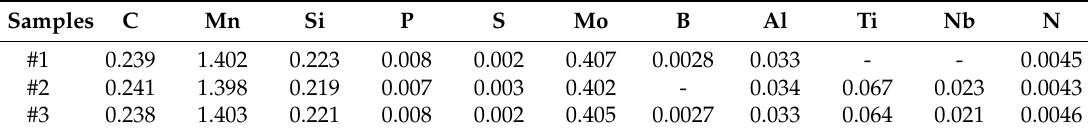
Table 1. Chemical composition of the investigated steel samples, wt%.